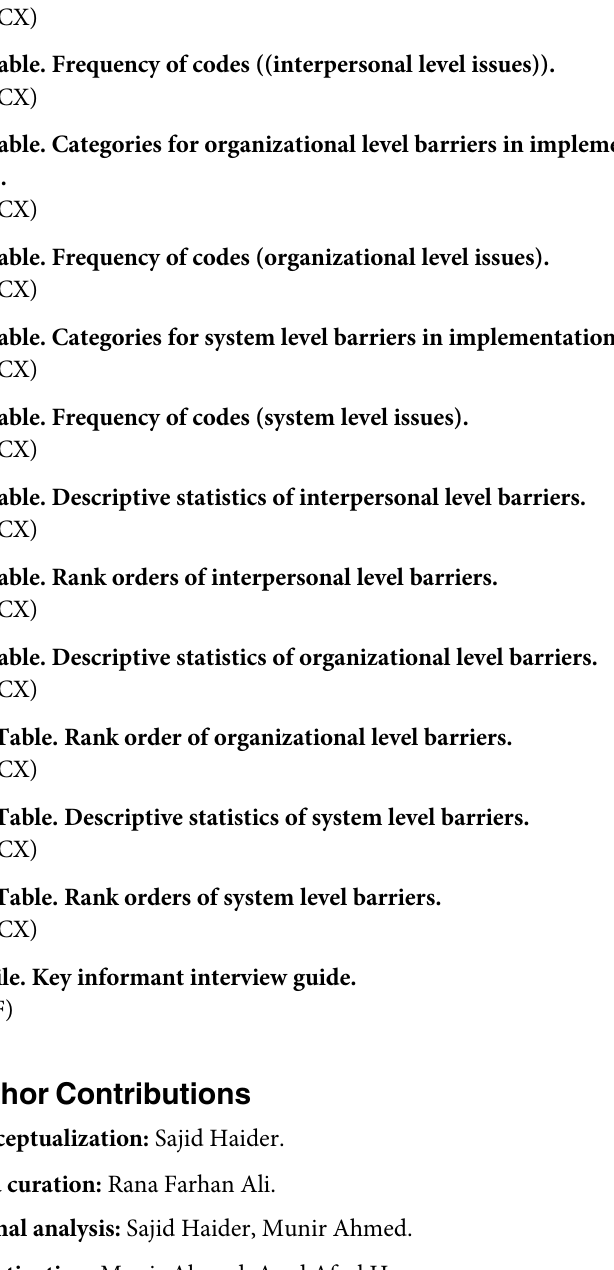
S1 Table. Categories for interpersonal level barriers in implementation of EmONC ser-